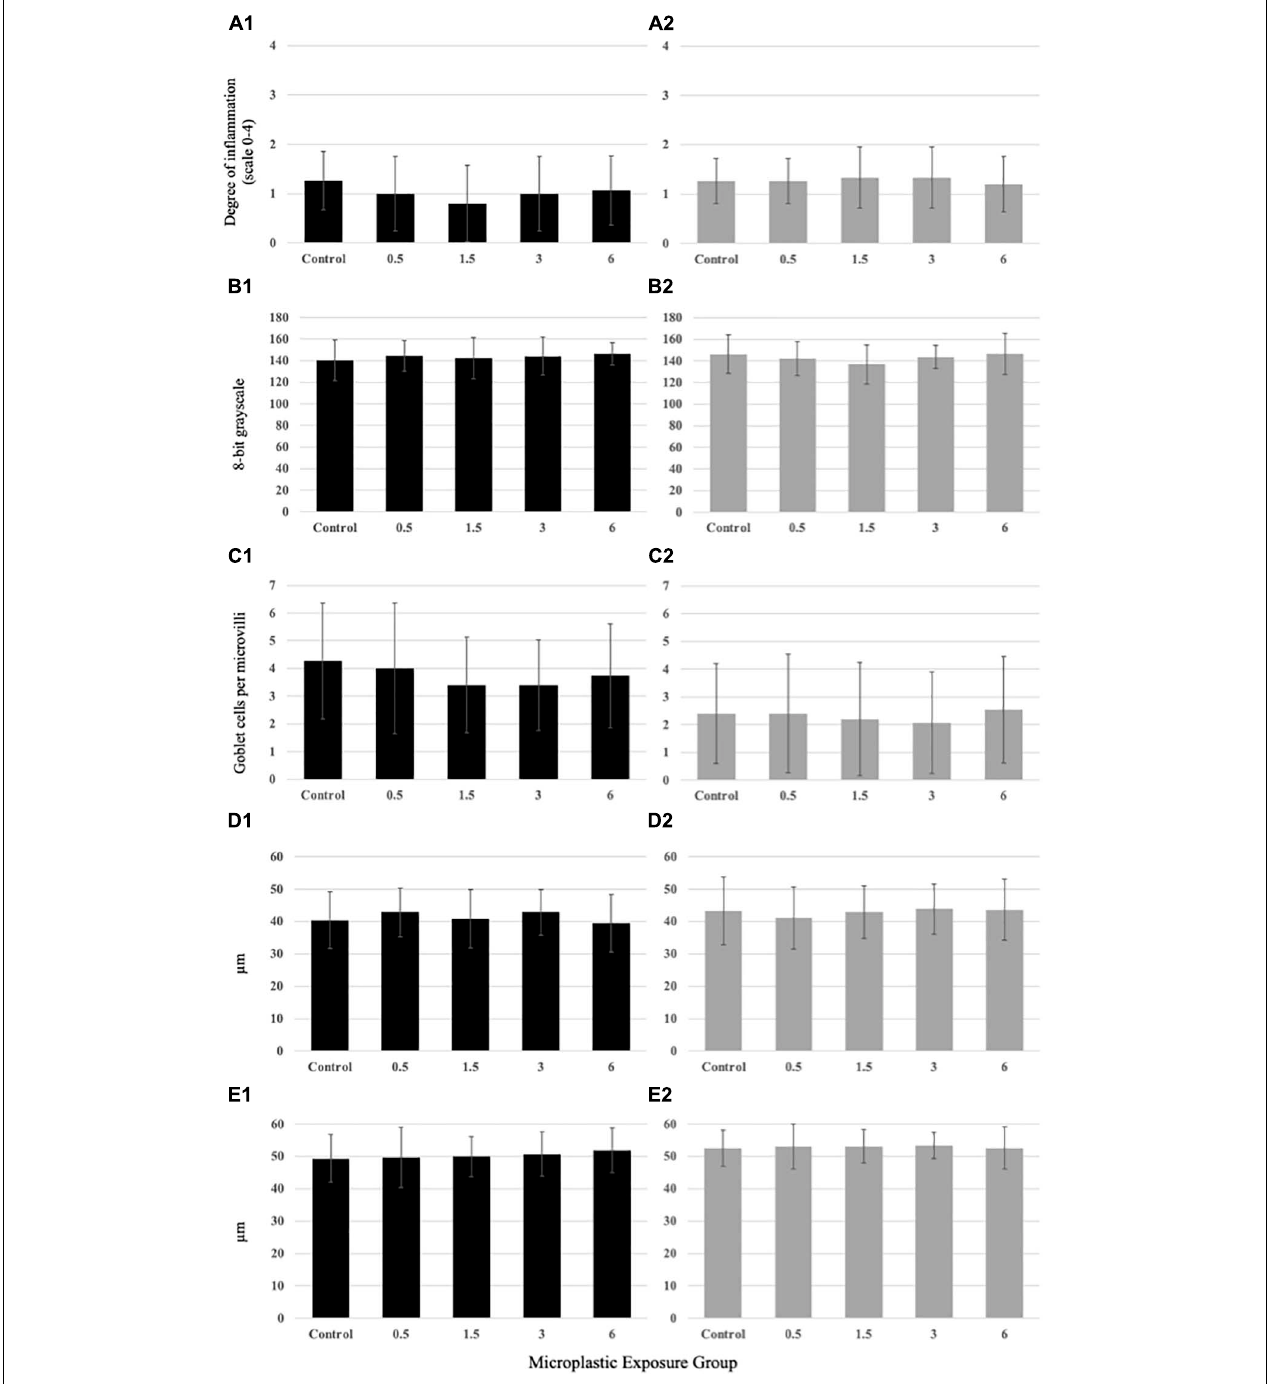
FIGURE 6 | Histological analysis results from larval (A1–E1) and juvenile (A2–E2) medaka exposed to PE fibers. No significant variation at the larval or juvenile life stage among the microplastic concentrations compared to the control for (A1,2) inflammation, (B1,2) mucus pH, (C1,2) goblet cell abundance, (D1,2) microvilli length, or (E1,2) microvilli width. Data are displayed as mean ± standard deviation (nested ANOVA, * p < 0.05, n = 5).